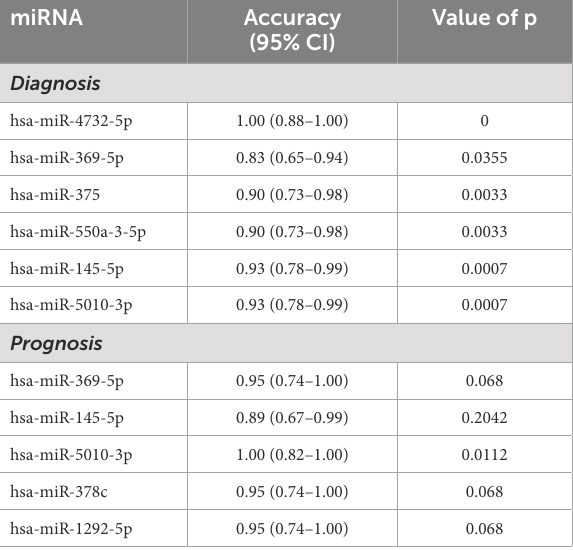
TABLE 2 Prediction power of serum exosomal miRNAs for the diagnosis and prognosis of MWoA patients.